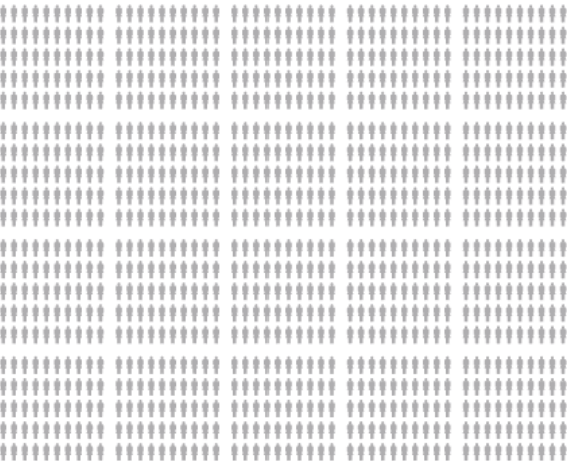
Figure A1. An Example of 10,000 Human-Shaped-Grid (Partial) for Risk